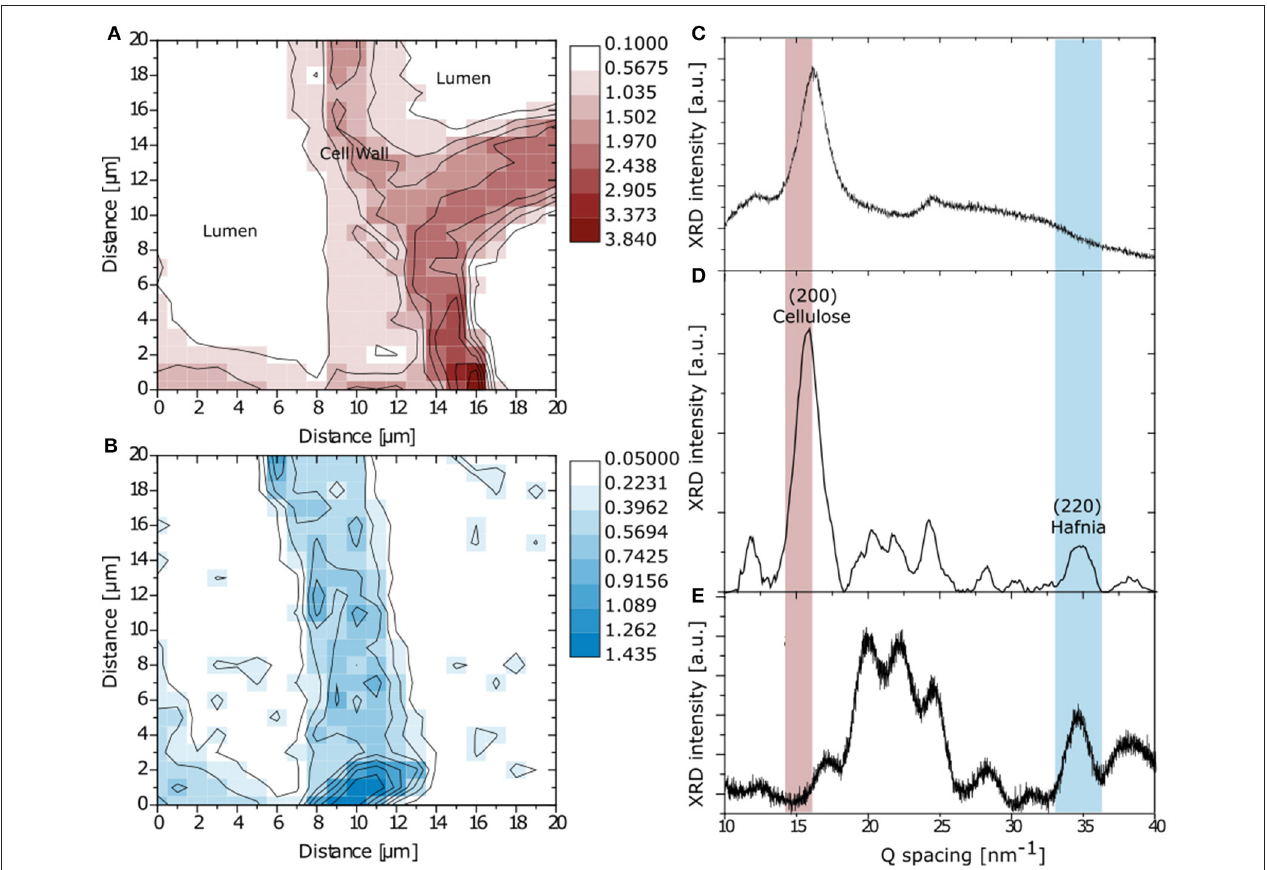
FIGURE 5 | Mapping of integrated intensity in Q-space over main cellulose reflection (200) (A) and Hafnia (220) (B) . Reference XRD pattern for spruce (C) and monoclinic Eu:HfO 2 (E) . Diffraction profile extracted from the mapping of the particle infiltrated wood sample (D)